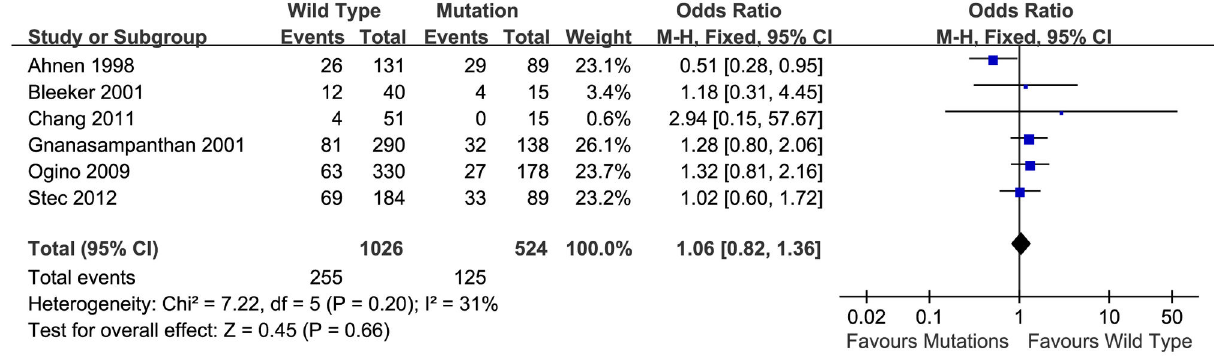
Figure 3. 3-year overall survival rate of wild type or mutant K-ras gene in patients received